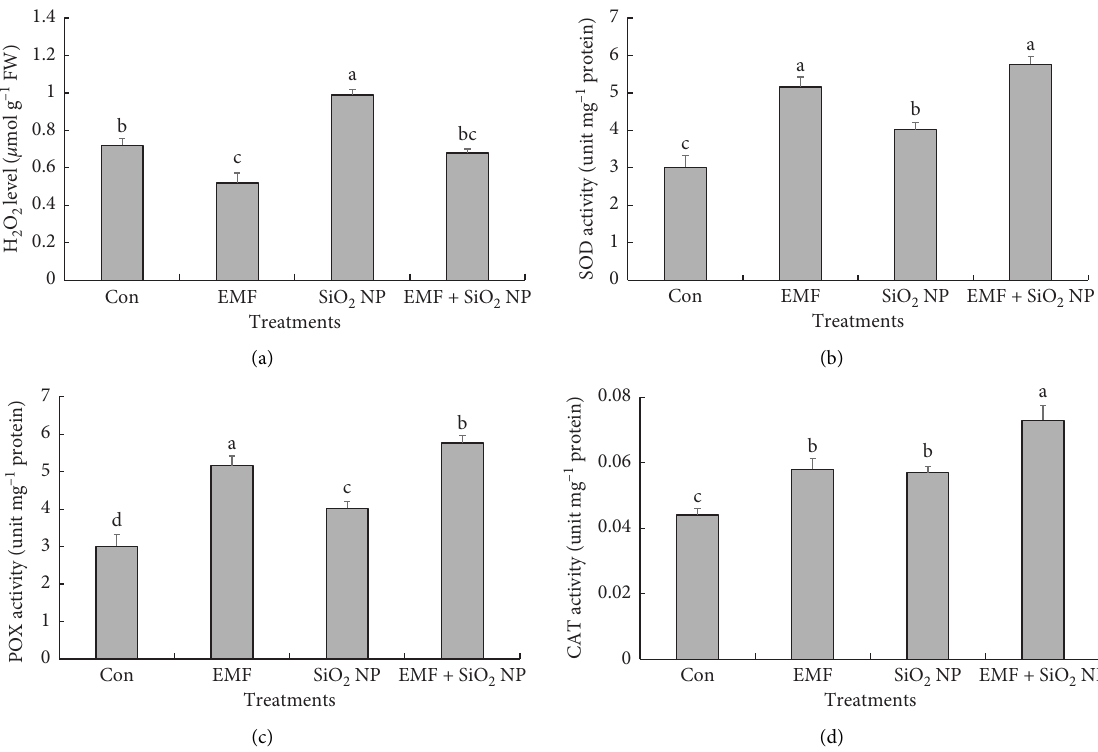
Figure 4: Impact of EMF and SiO 2 NP treatments on H 2 O 2 content (a), SOD activity (b), POX activity (c), and CATactivity (d) in A. gilanica plants. Bars indicate means ± SE ( n � 3) in each group. Different letters indicate significant differences at P ≤ 0 . 05.